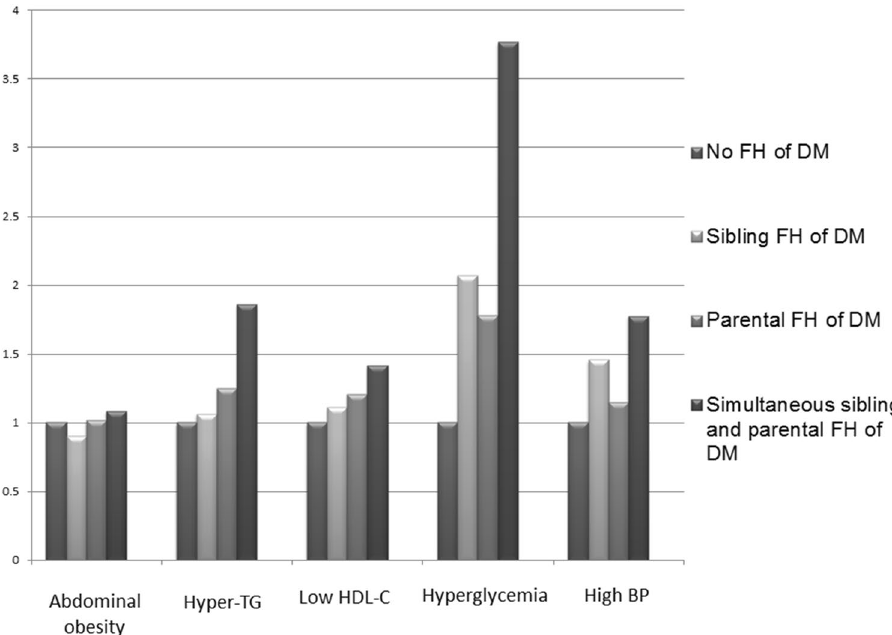
Figure 2. The correlation between the study groups with each component of MetS. Synergistic effect of sibling FH and parental FH of DM on the association of hyperglycemia component of